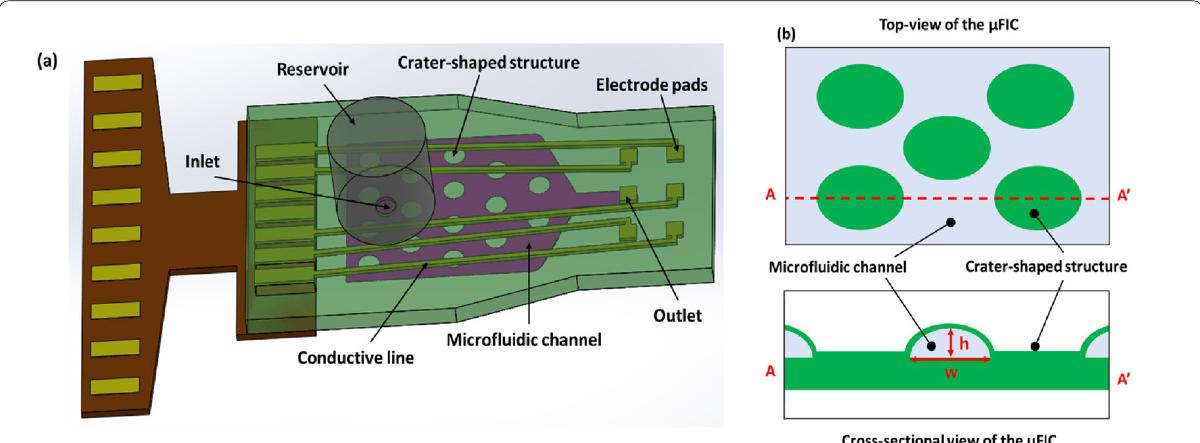
Fig. 1 Schematic diagram of a microfluidic flexible interconnection cable (μFIC). a Full conceptual image of the μFIC. The fluid in the reservoir flows to the inlet of the μFIC. The microfluidic channel has crater‑shaped structures. b Top view (left) and cross‑sectional view (right) of the